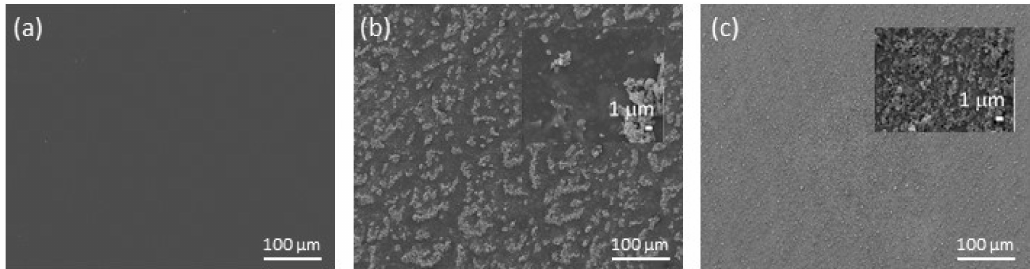
Figure 1. Scanning electron microscope (SEM) images of pure epoxy coating ( a ) and the epoxy / fluoroalkylsilane (FAS)-TiO 2 / epoxy ( b ) and epoxy / TiO 2 / epoxy ( c ) coatings. The insets in ( b ) and ( c ) show the characteristic dimensions of agglomerates.